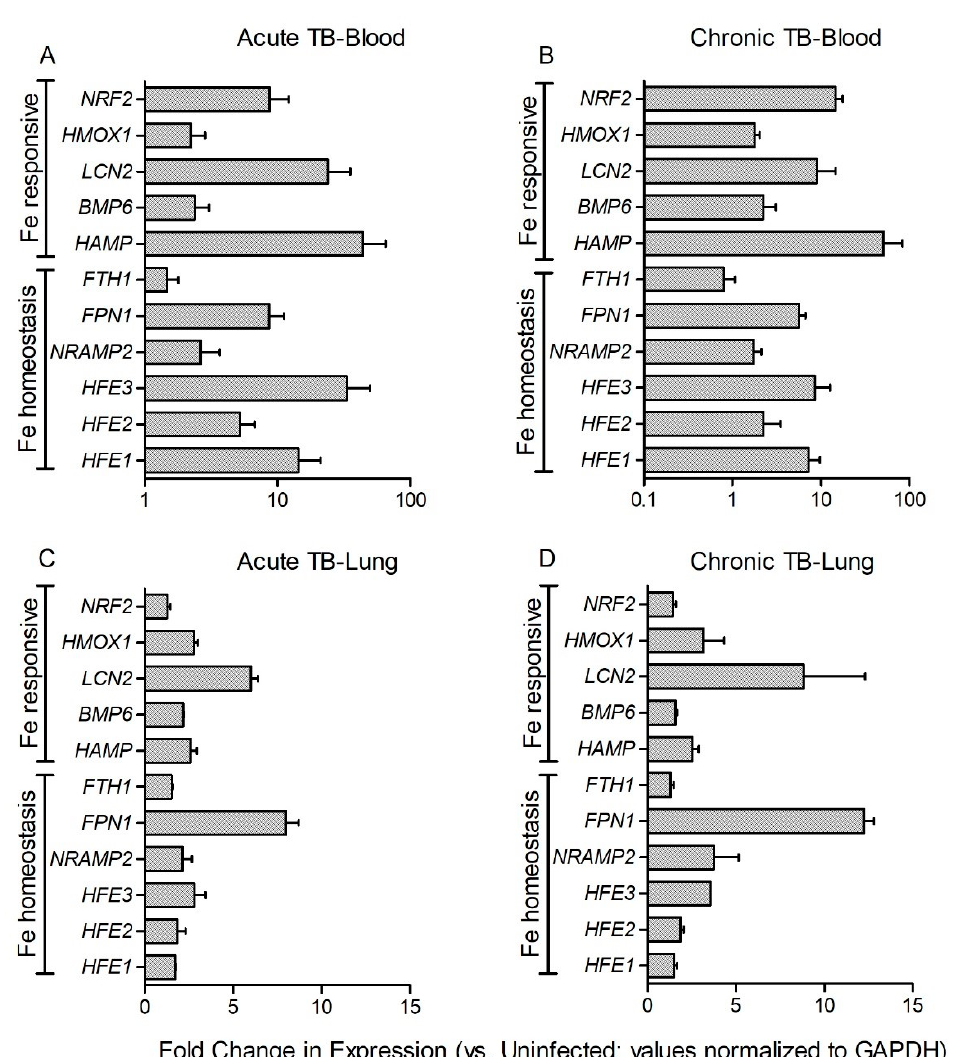
Figure 3. Expression of iron-responsive genes in Mycobacterium tuberculosis (Mtb)-infected rabbits